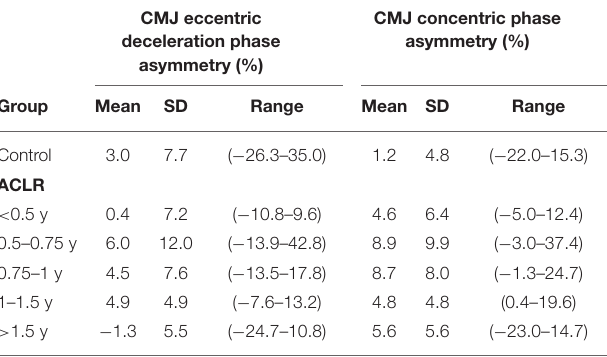
TABLE 4 | Descriptive statistics for phase-specific between-limb asymmetry for the non-injured controls and anterior cruciate ligament reconstructed (ACLR) group stratified by time-since-surgery.